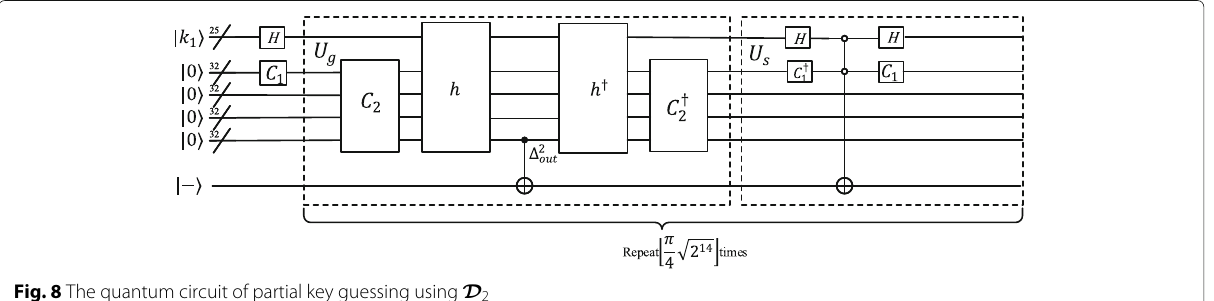
Fig. 8 The quantum circuit of partial key guessing using D 2